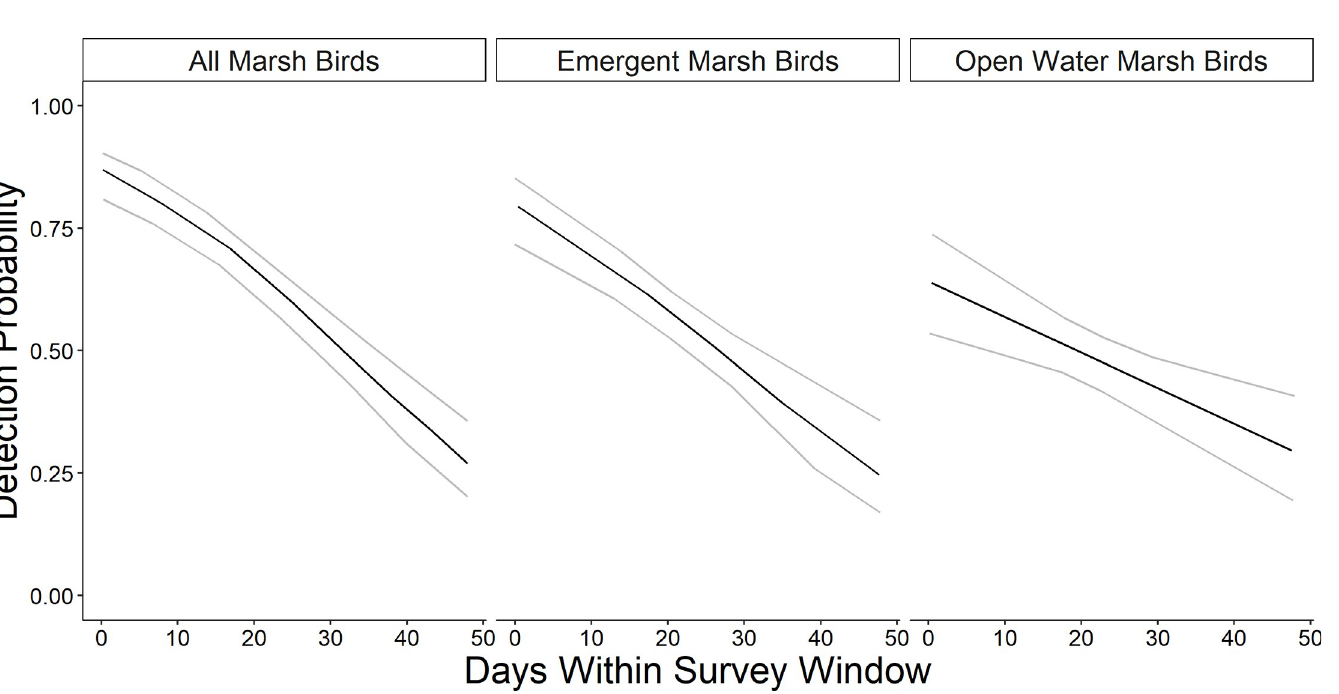
were considered non-competitive ( w < 0.03) and thus, excluded from further consideration i (Table 3). The probability of occupancy increased 28 times (odds ratio = 28; 95% CI = 2–37) between the lowest and highest level of wetland complexity (Fig 4). The probability of occu- pancy was 5 times greater (odds ratio = 5; 95% CI = 2–12) at wetlands managed for waterfowl compared to NWI wetlands (Fig 5). Moreover, probability of occupancy decreased 0.30 times